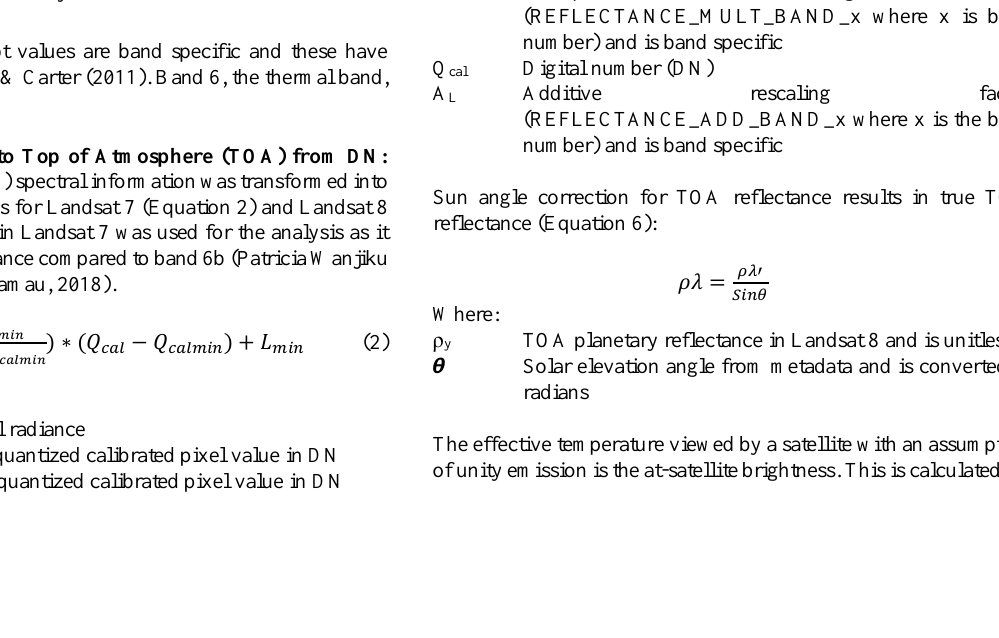
Where DN7 and DN5 are the digital numbers of Landsat 7 ETM+ and Landsat 5 TM